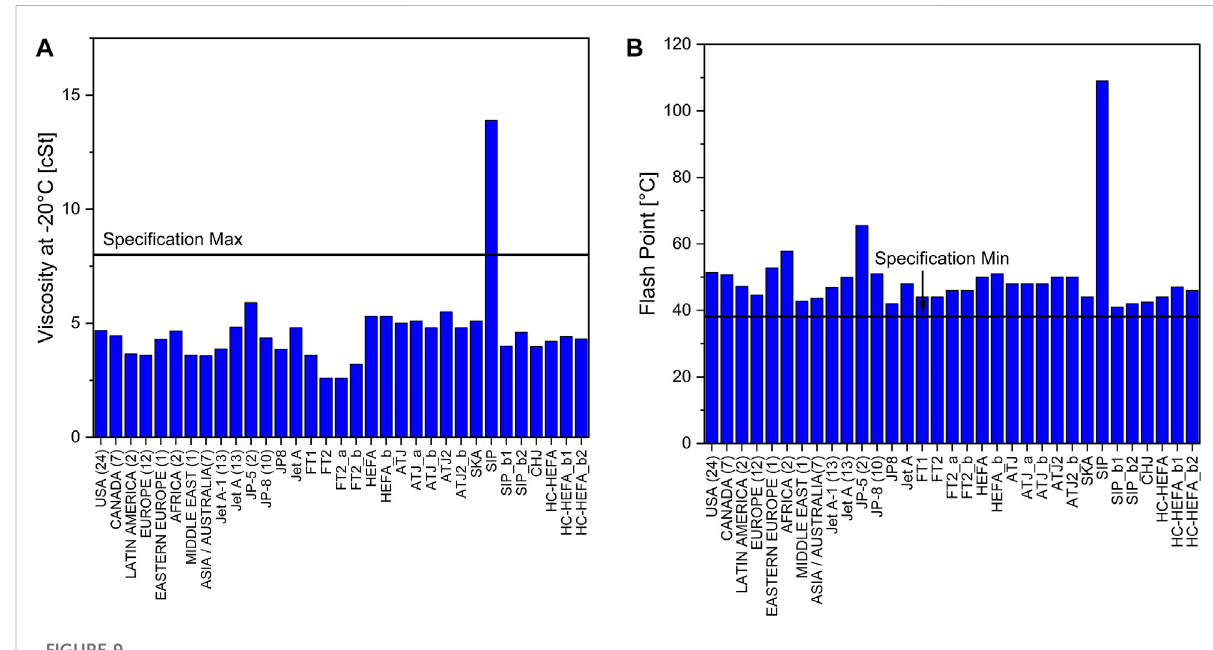
FIGURE 9 Results for WFS and SAF (A) viscosity at − 20 ° C and (B) fl ash